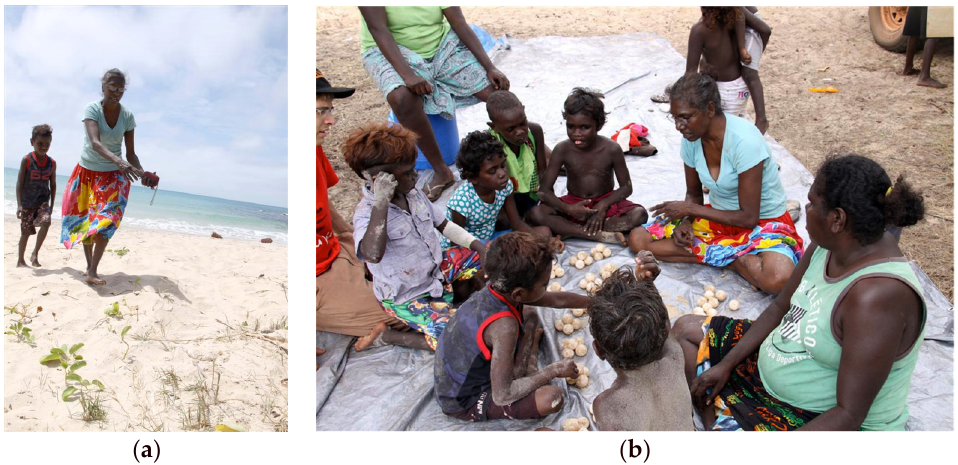
Figure 3. ( a ) Merrkiyawuy identifying miyaupu tracks; ( b ) counting miyaupu mapu with Yirrkala School children.